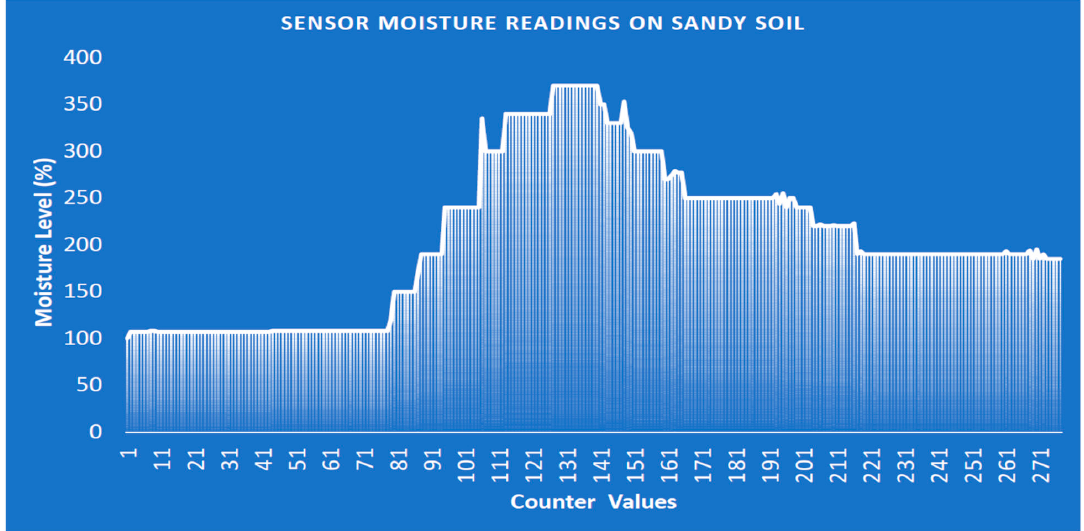
Figure 21. Soil moisture level against counter values on sandy soil.